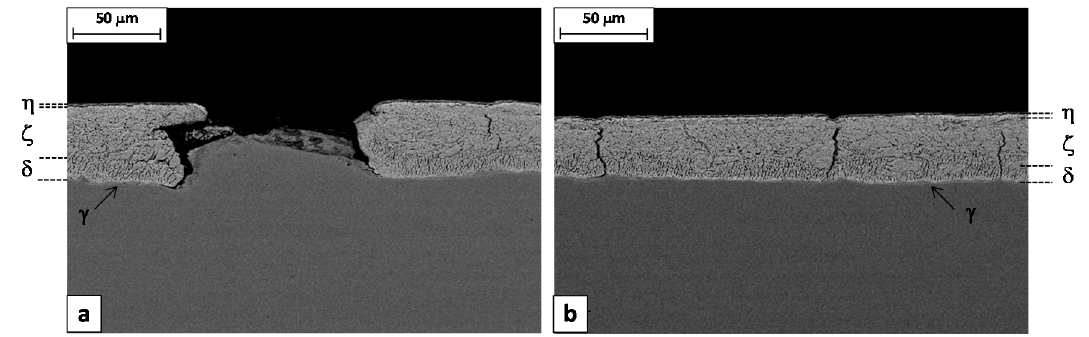
Figure 5. SEM images of Steel 1 wire sections: ( a ) defect cross section and ( b ) far from the defect and EDS chemical analysis of the bulged steel surface.